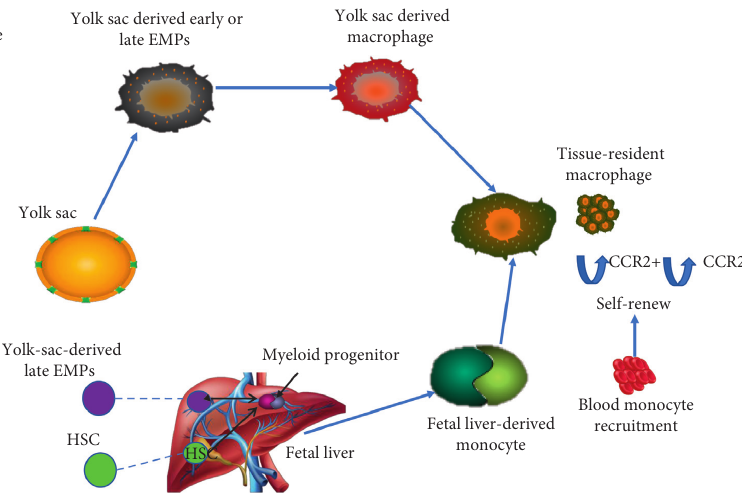
Figure 1: Macrophages in the normal